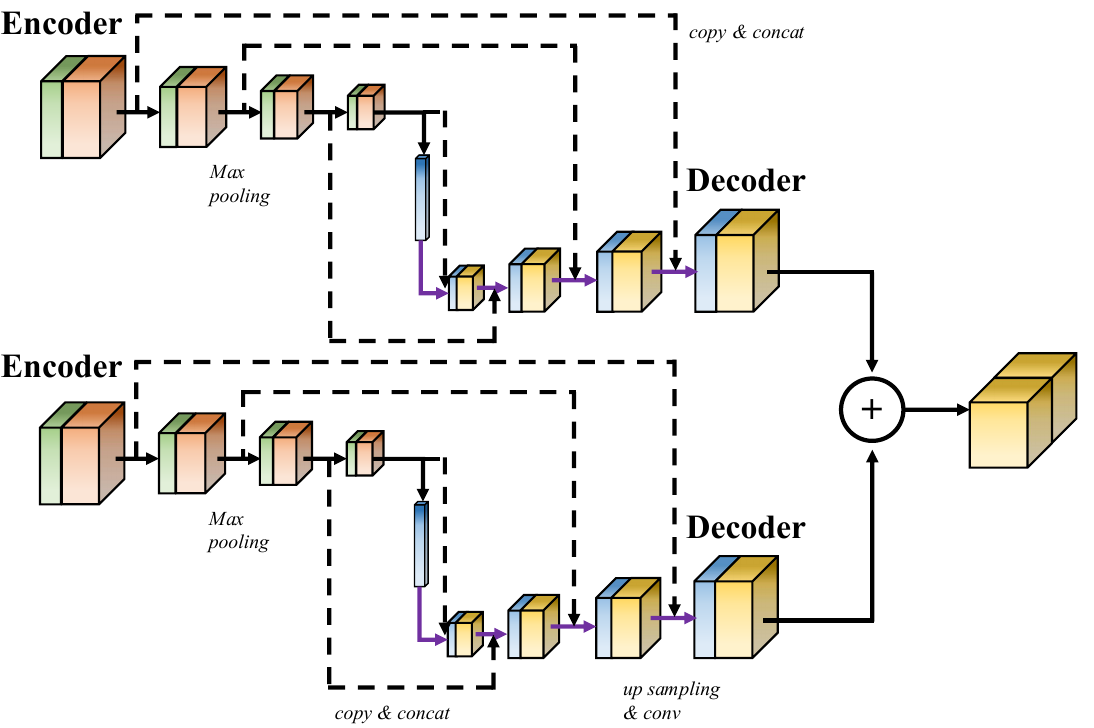
Figure 3. The two-branch backbone based on the rectified encoder–decoder structure. The encoder is on the left side, and the decoder is on the right